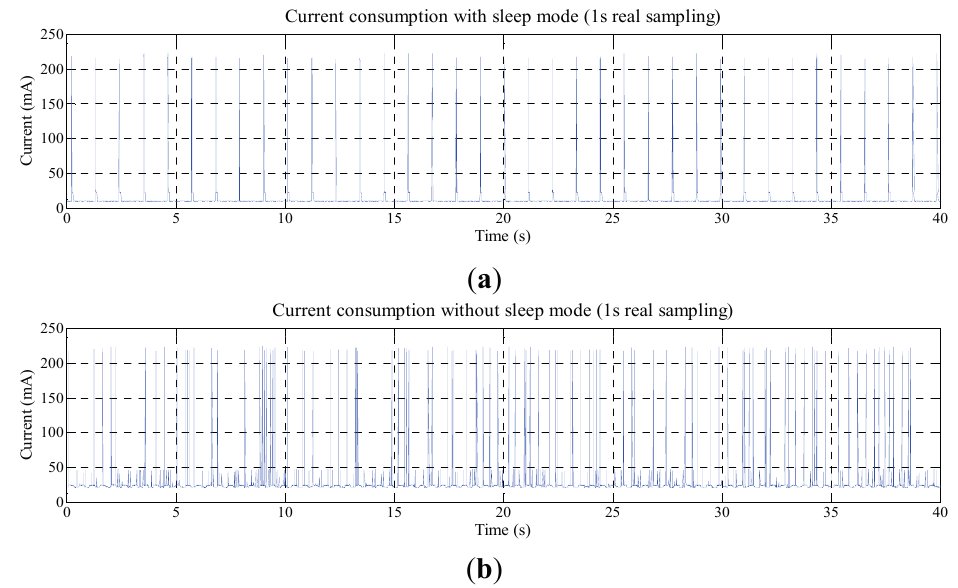
Figure 9. Current consumption during WNCS operation WNCS operation with sampling rate of 1 s ( a ) XBee module using sleep mode; ( b ) XBee module not using sleep mode.